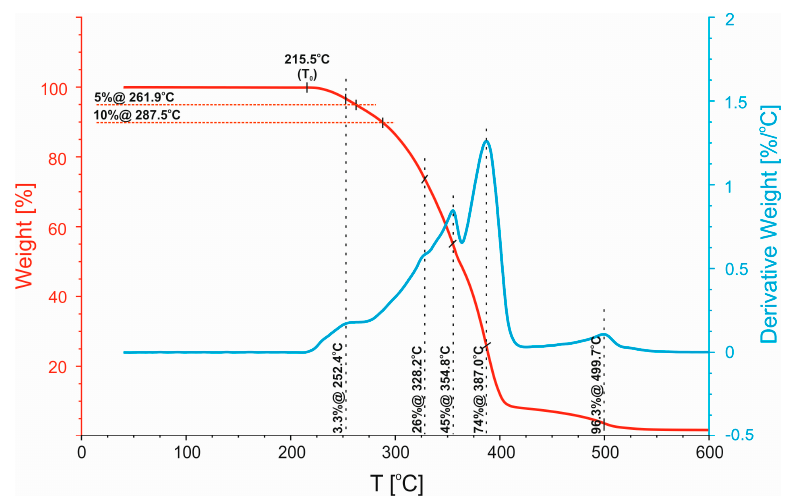
Figure 7. Non-isothermal analysis of TG and DTG thermograms of the uncompatibilized 50/50 PP/PBT blend.